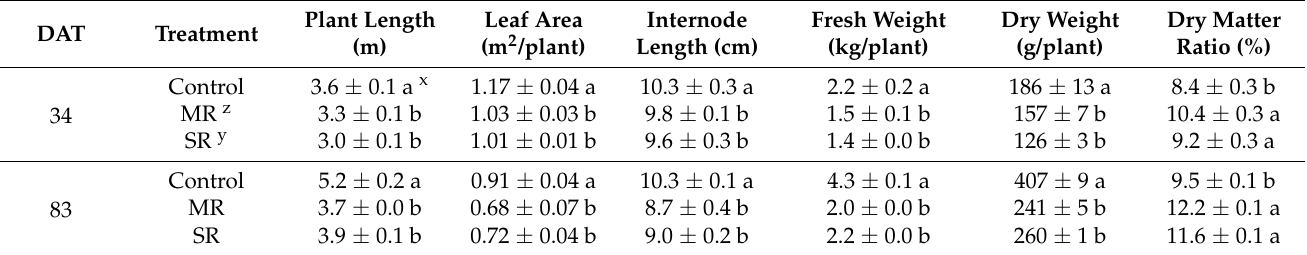
Table 2. Effect of water stress on the growth of tomatoes recorded at 34 and 83 days after commencing treatment (DAT).